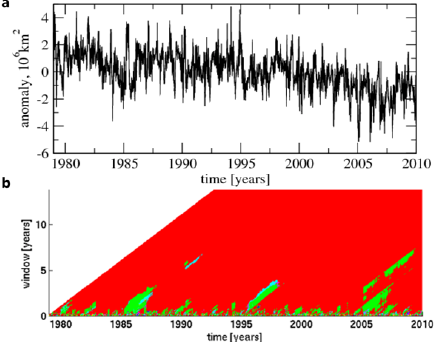
Fig. A5. Potential analysis of equivalent sea-ice extent index. (a) Dataset constructed by Eisenman (2010) and available at ftp: //ftp.agu.org/apend/gl/2010gl043741, which is based on the latitude of the Arctic sea ice edge where the ice is free to migrate, con- verted to an equivalent area, assuming there were no land masses in the high northern latitudes. (b) Contour plot of number of de- tected states, where red=1 detected state, green=2, cyan=3, and magenta=4. Results plotted as a function of sliding window length at the end of the window. No bifurcation is detected in this dataset, because it has much higher internal variability than sea ice extent (Fig. A3g). Recent observed ice extent anomalies are dwarfed by earlier, larger fluctuations that are inferred to have occurred had the continents not got in the way of winter ice variations.